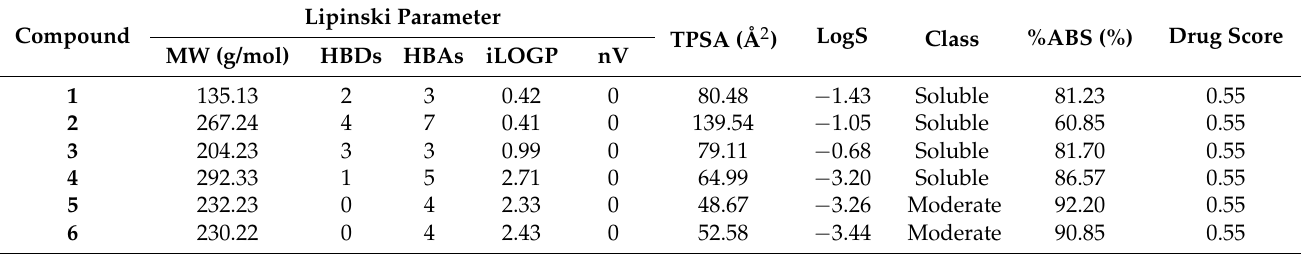
Table 4. ADMET parameters found for the compounds 1 – 6 using the free toolbar SwissADMET Predictor. Lipinski Compound